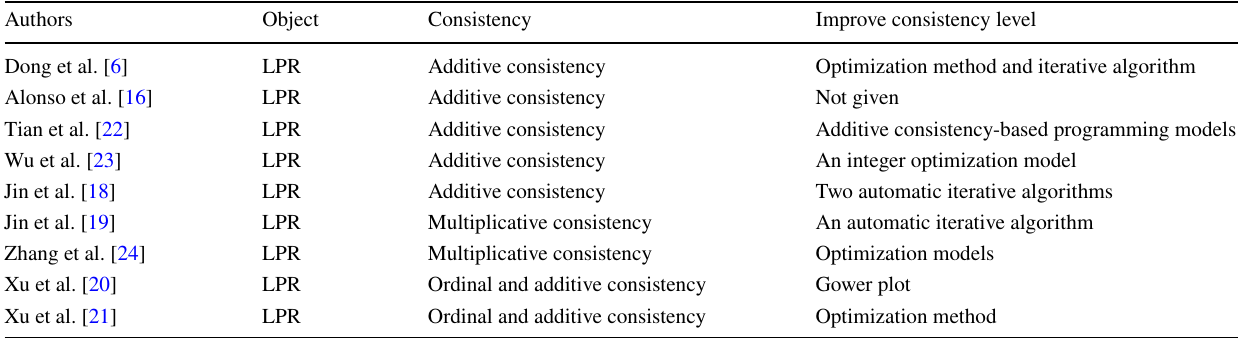
Table 1 Comparison of consistency analysis of linguistic preference